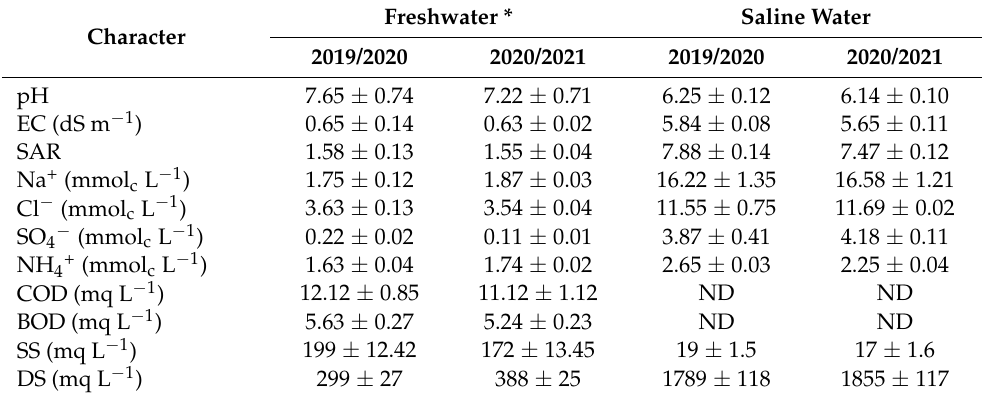
Table 2. Characterization of irrigation water during the 2019/2020 and 2020/2021 growing seasons.